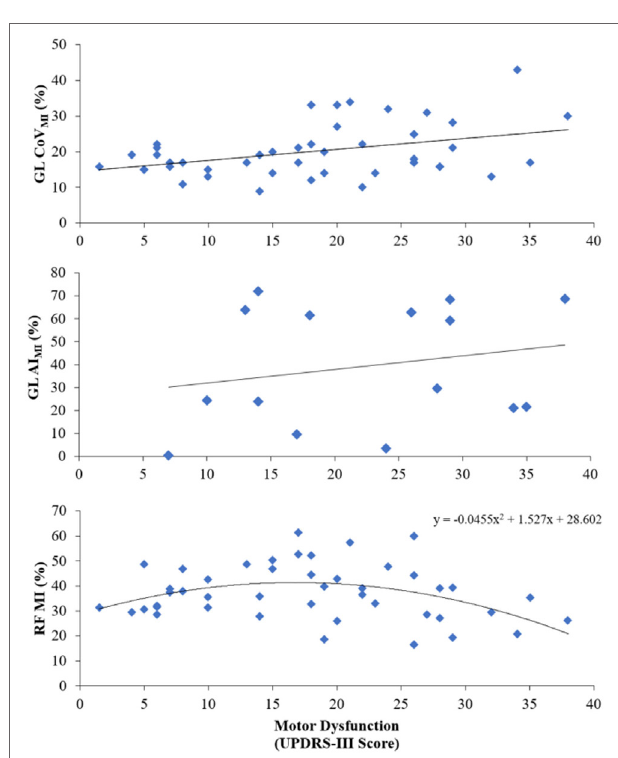
FigUre 3 | Main relationships seen between motor dysfunction and pooled-session variability of the gastrocnemius lateralis modulation index (GL CoV MI ), pre-intervention gastrocnemius lateralis modulation index asymmetry (GL AI MI ), and pooled-session rectus femoris modulation index (RF